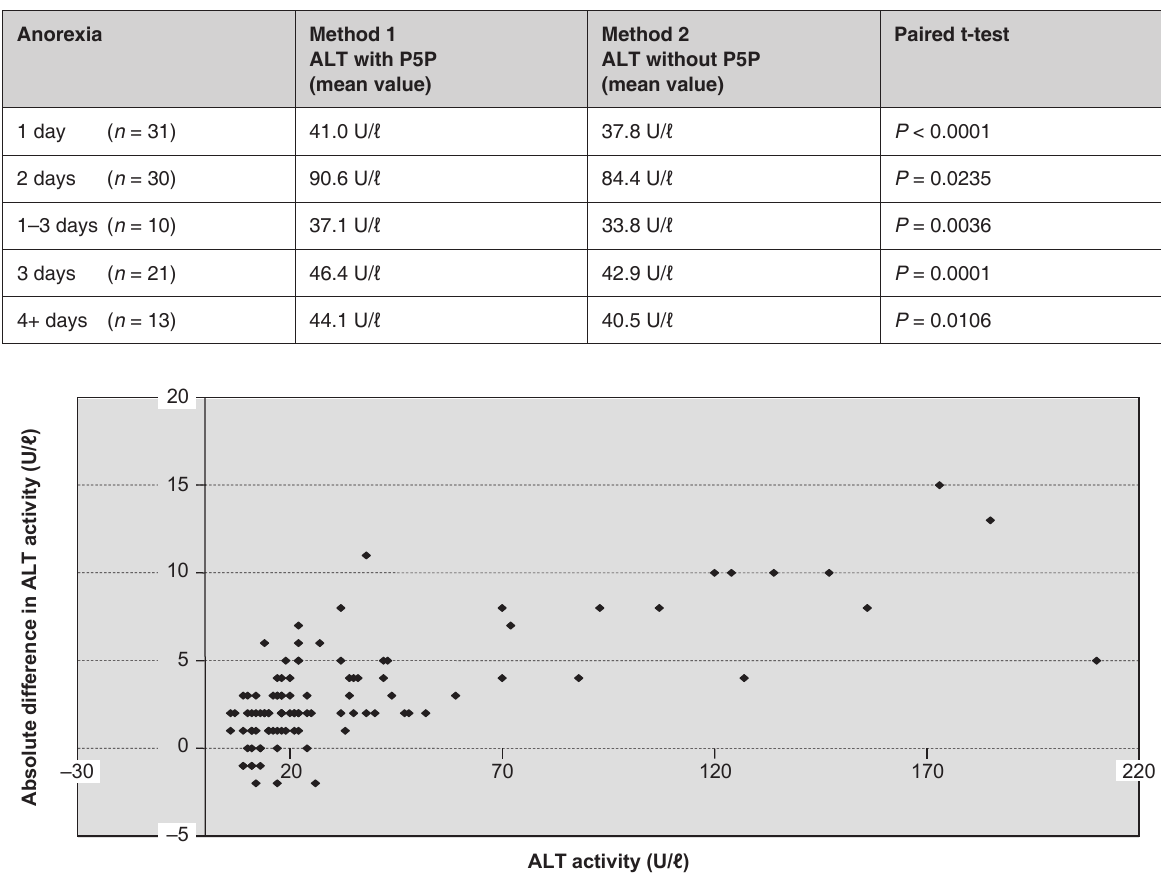
The Bland­Altman absolute difference plot related to ALT activity in the Babesia ­infected